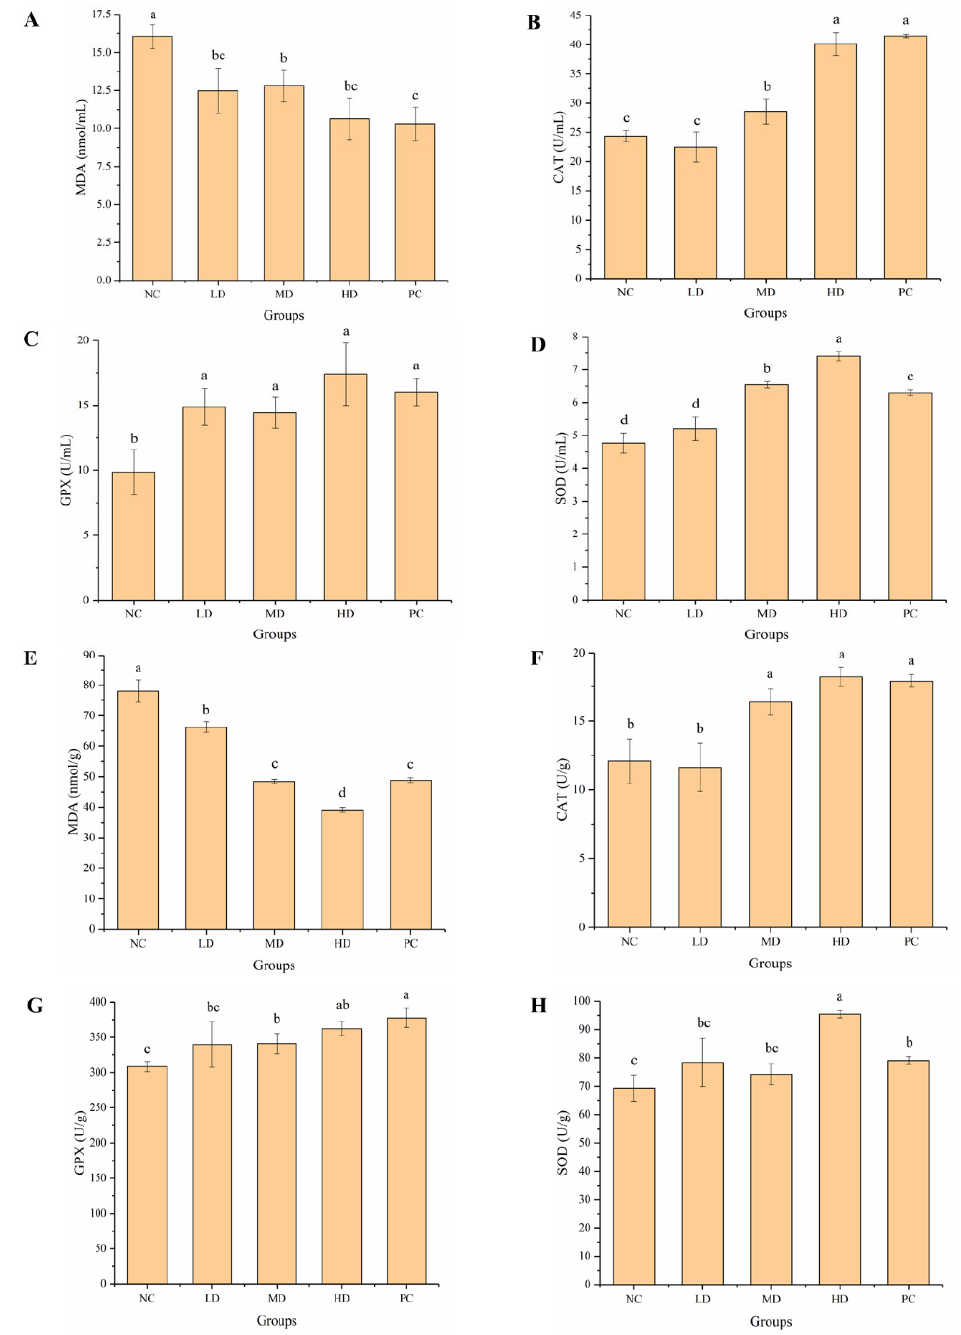
Figure 7. Effect of HGP on serum and brain antioxidant levels in mice. ( A ) Malondialdehyde (MDA) in serum of mice from different groups. ( B ) Catalase (CAT) in serum of mice from different groups. ( C ) Glutathione peroxidase (GPX) in serum of mice from different groups. ( D ) Superoxide dismutase (SOD) in serum of mice from different groups. ( E ) MDA in brains of mice from different groups. ( F ) CAT in brains of mice from different groups. ( G ) GPX in brains of mice from different groups. ( H ) SOD in brains of mice from different groups. Different lowercase letters represent significant differences between groups ( p < 0.05). NC: normal control, LD: low dose, MD: middle dose, HD: high dose, PC: positive control. 4. Discussion In recent years, studies have found that excessive production of free radicals is an important cause of fatigue. Long ‐ term work and long ‐ term and high ‐ intensity exercise can lead to an excessive increase in free radicals, which can easily lead to fatigue. The mechanism of antioxidation is closely related to the scavenging of free radicals, and a series of studies on the relationship between anti ‐ fatigue activity and antioxidant activity have been carried out. Studies have shown that anti ‐ fatigue function is closely related to